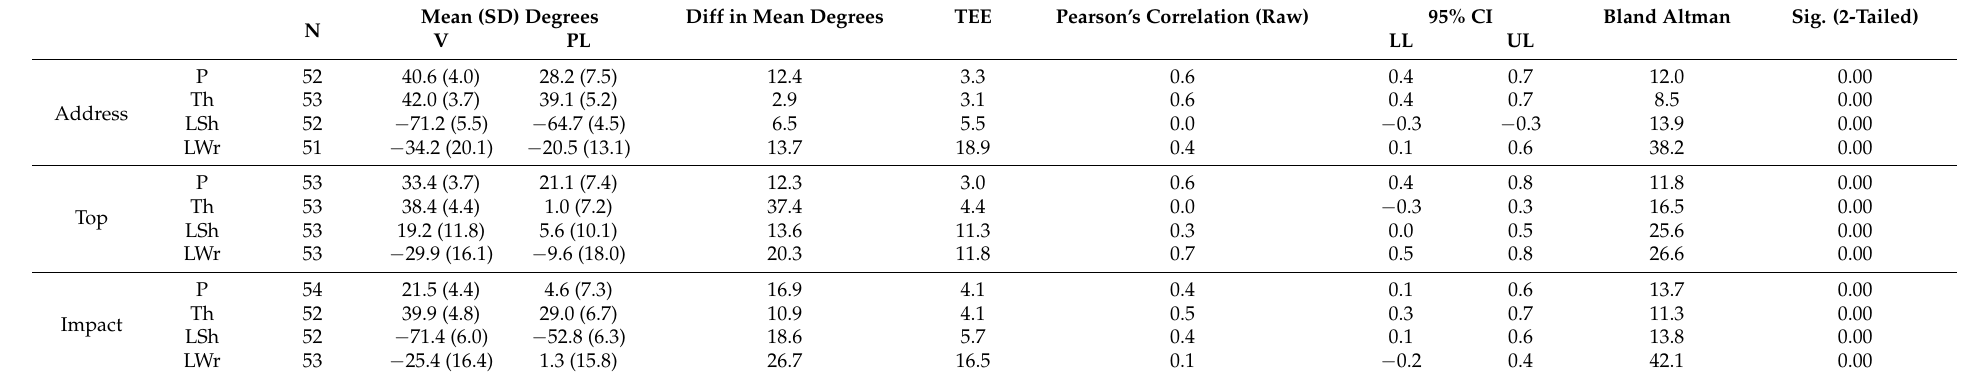
Table 5. Comparison between Polhemus Liberty (practical) and VICON Nexus (criterion) in the medial/lateral axis.